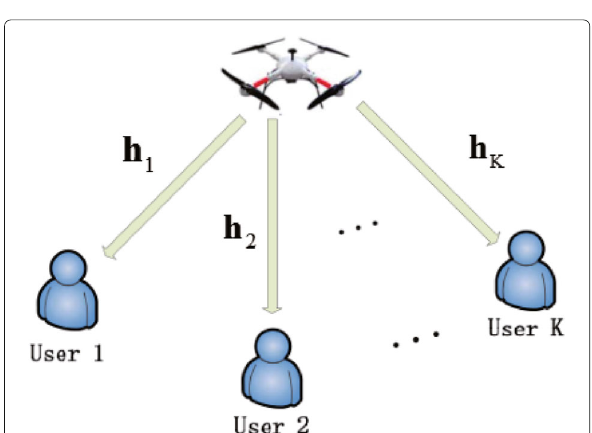
Fig. 1 A NOMA-enabled multicast-unicast transmission